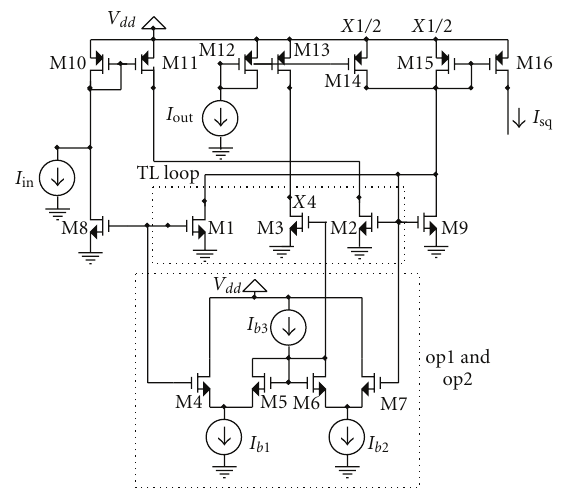
Figure 4: Circuit diagram of the proposed two-quadrant squarer/divider. Table 1: Aspect ratios of transistors in Figure 4. Transistor